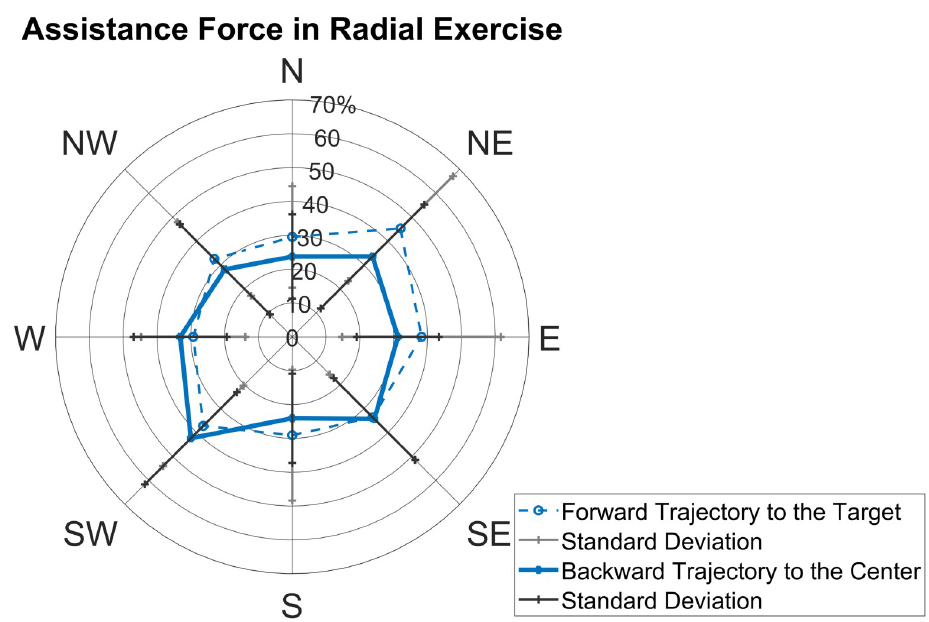
Fig 9. Radial assistance level. Mean inter-subject assistance and deviation in the Radial task, displayed for trajectories towards the targets and back to the center.